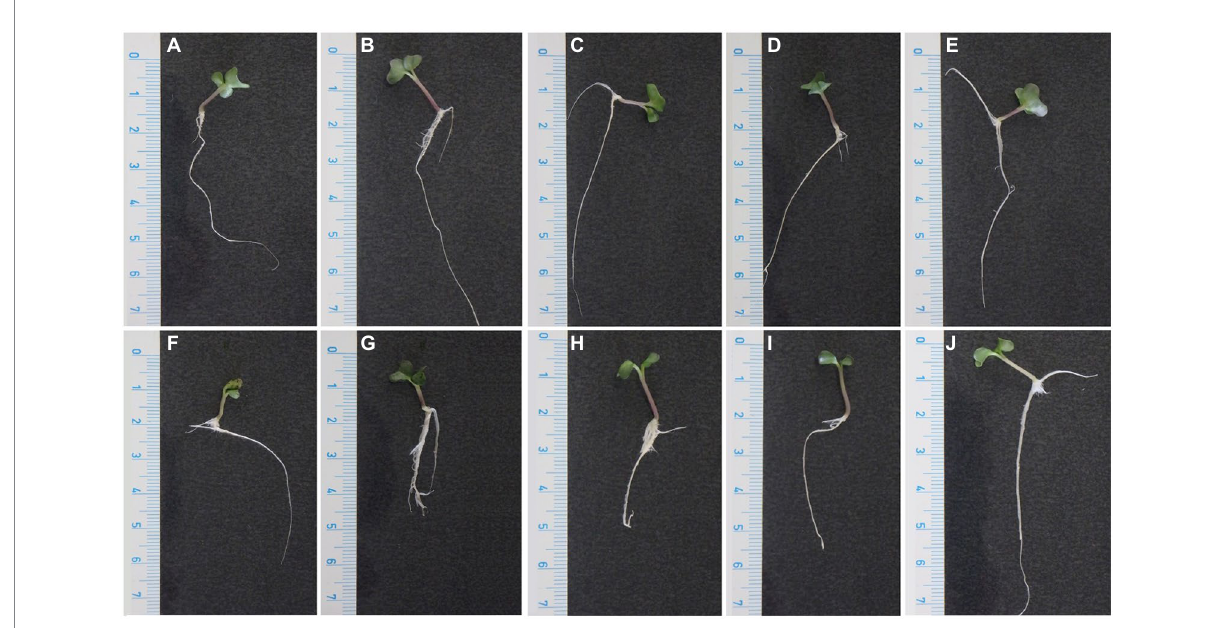
FIGURE 5 Effect of phenolic treatments on black rot symptoms and cabbage plant vigor. Pictures on top (A–E) correspond to 10 days old seedlings obtained from seeds inoculated with sterile PBS and: without further treatment (A) , treated with sterile PBS (B) , treated with 0.078% carvacrol (C) , treated with 0.3125% thymol (D) , and treated with a combined solution of 0.0098% carvacrol +0.039% thymol (E) . Pictures at the bottom (F–J) correspond to 10 days old seedlings obtained from seeds inoculated with a suspension of Xanthomonas campestris pv. campestris strain WHRI 3811 and: without further treatment (F) , treated with sterile PBS (G) , treated with 0.078% carvacrol (H) , treated with 0.3125% thymol (I) , and treated with a combined solution of 0.0098% carvacrol + 0.039% thymol (J) .